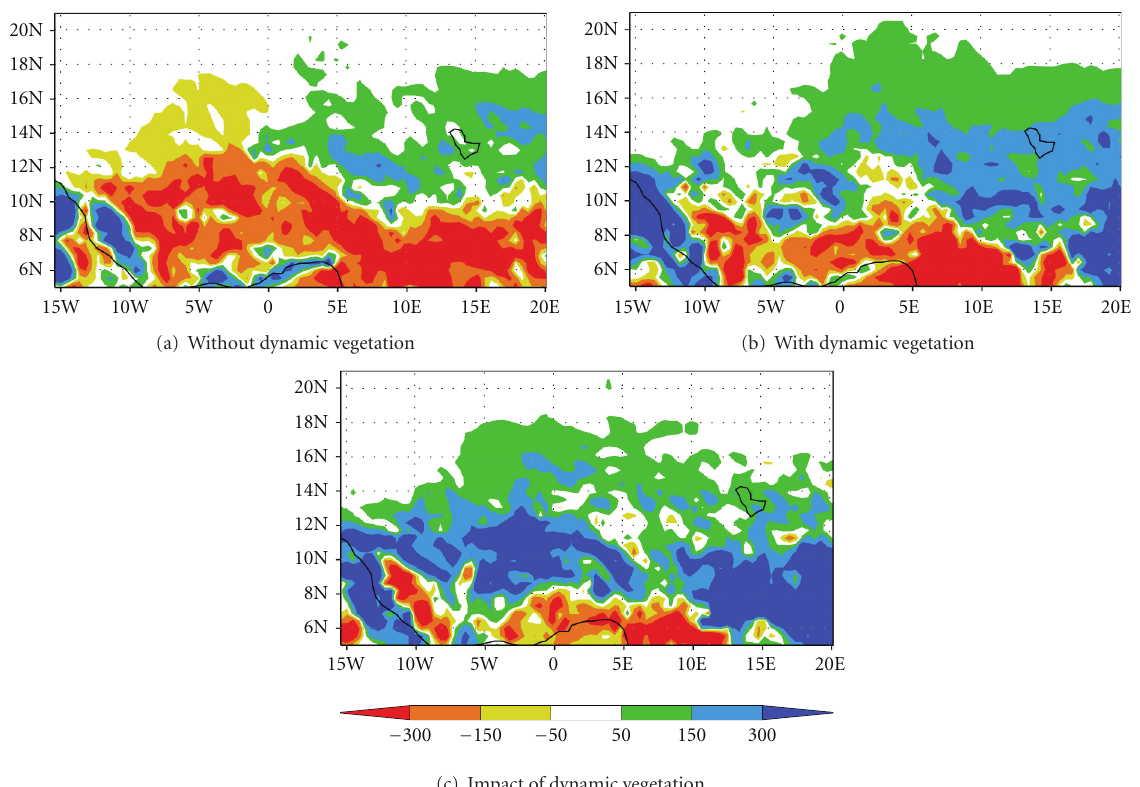
Figure 1: Changes in annual precipitation (in mm) simulated without dynamic vegetation (i.e., “Future nv”—“Present”), with dynamic vegetation (i.e., “Future”—“Present”), and the contribution due to dynamic vegetation feedback (i.e.,